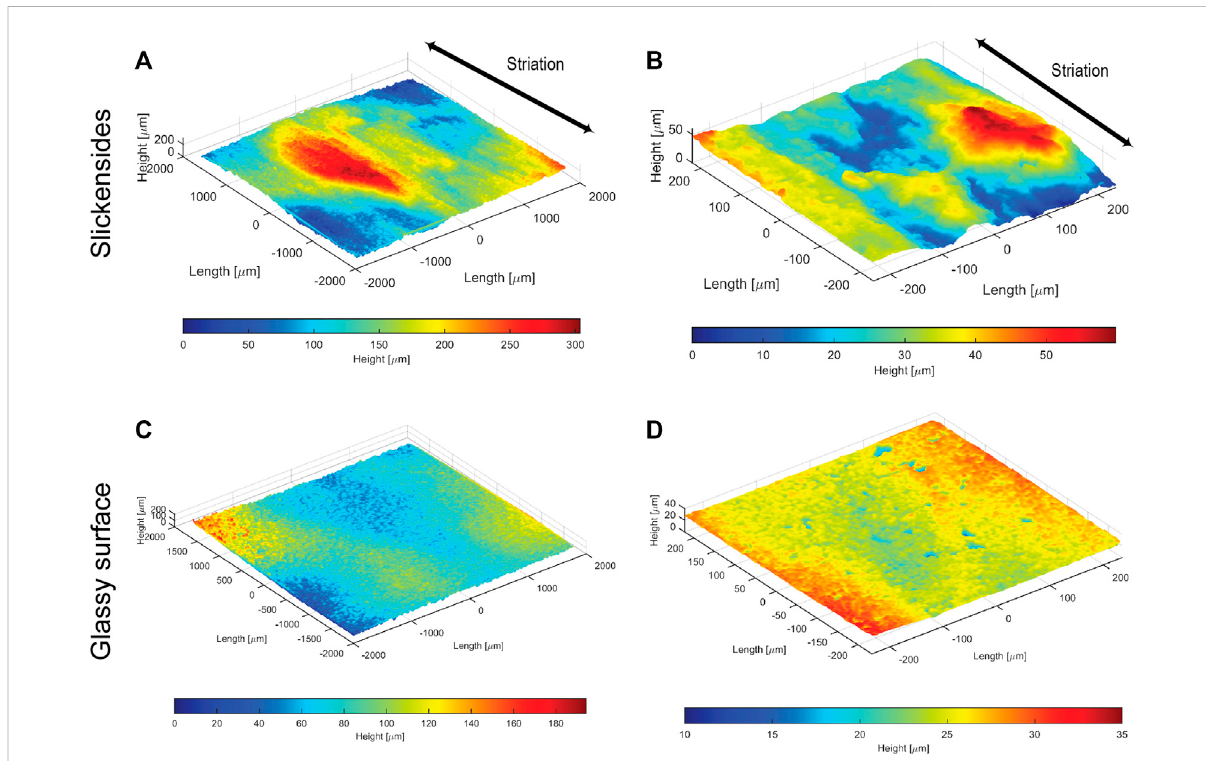
FIGURE 3 Measured topography of the fracture surfaces at different magni fi cations. (A) Slickenside topography measured with an optical lens at ×2.5 magni fi cation. (B) Slickenside topography measured with an optical lens at ×20 magni fi cation. (C) Same as (A) but for the glassy fracture surface. (D) Same as (B) but for the glassy fracture